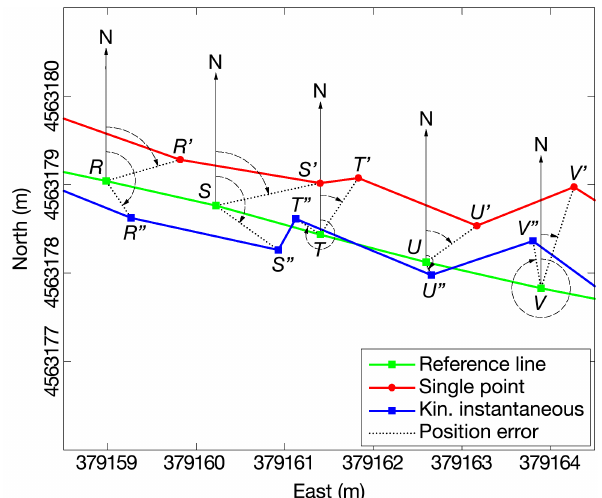
Figure 2. Scheme of the quantification of errors in the kinematic GPS horizontal positions referred to a portion of the trajectory.